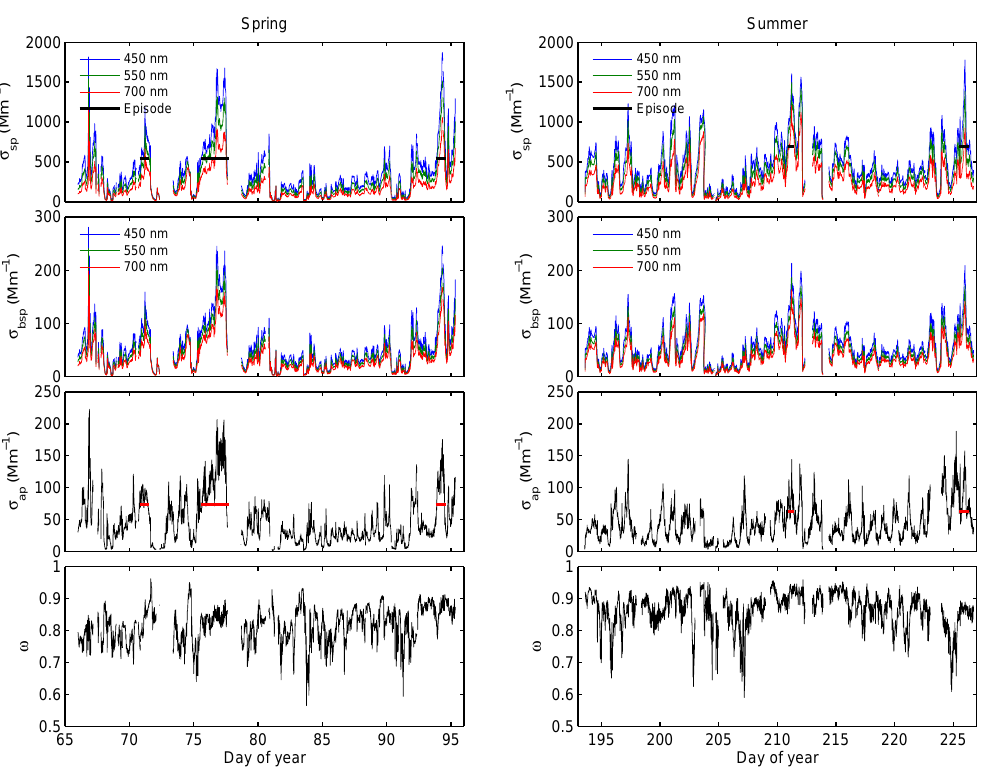
Fig. 5. Time series of measured σ sp , σ bsp , σ ap and ω in spring and summer campaign. The horizontal short lines denote the episodes.